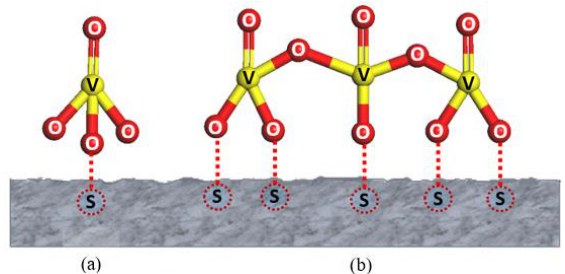
Figure 2. ( a ) Isolated VO 4 species on the support (s); and, ( b ) Polymeric VO 4 species on the support (s).